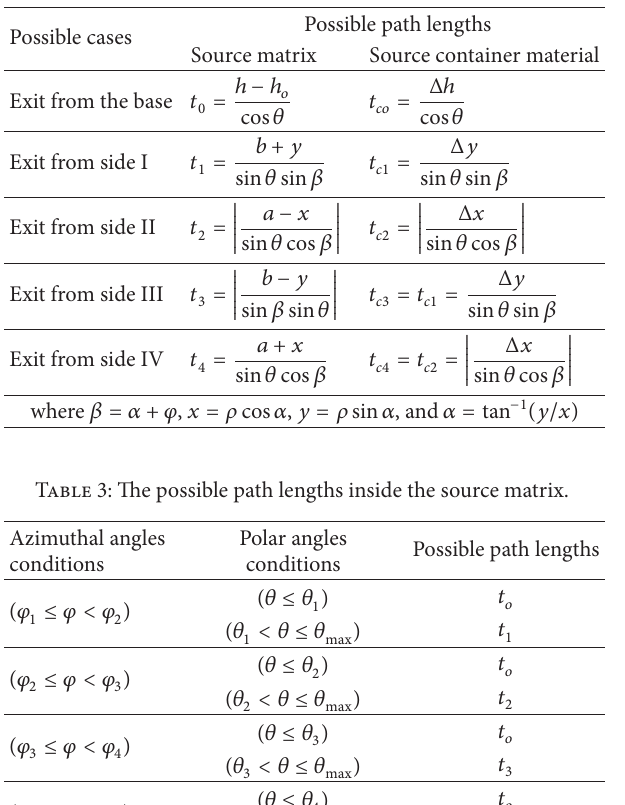
Table 2: The values of the polar and the azimuthal angles of the source matrix and the source container material. Possible path lengths Possible cases Source matrix